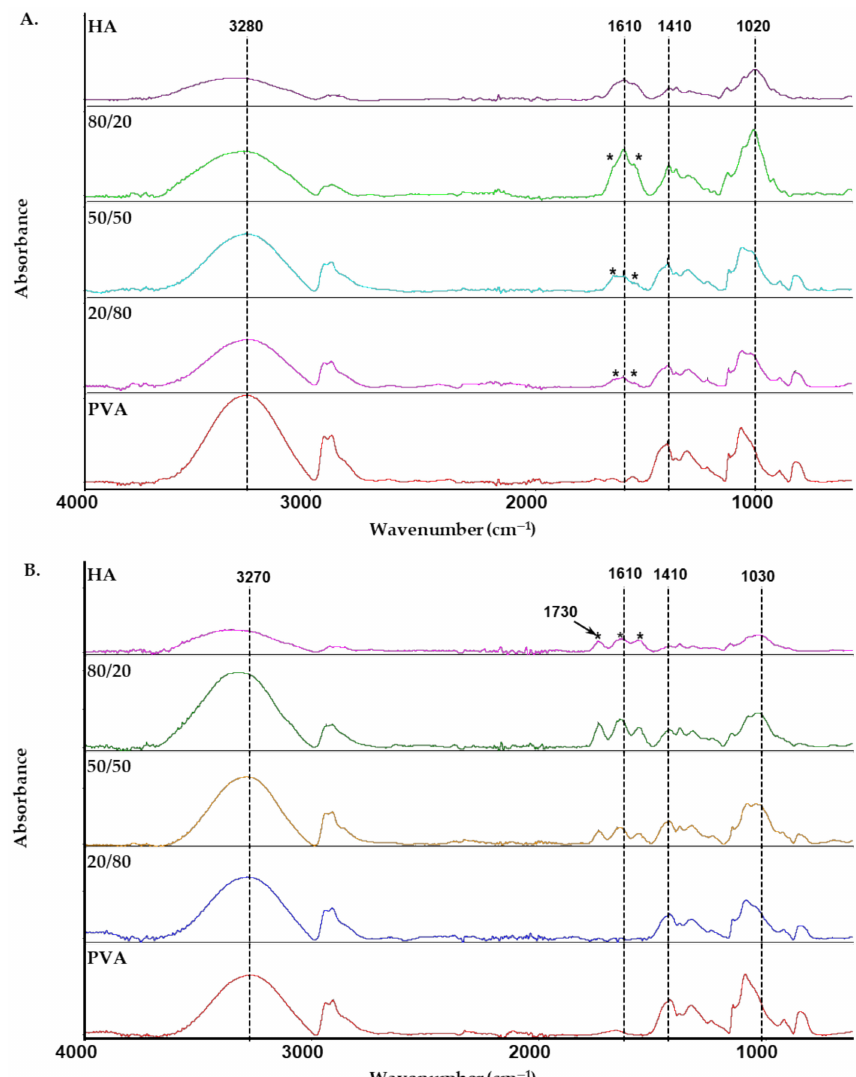
Figure 6. Attenuated Total Reflectance (ATR)–infrared spectra of HA, PVA and their blend films in various solvents: ( A ) distilled water; ( B ) 0.1 mol dm − 3 HCl. The interactions occurring in HA / PVA blend films between the components are visible by marked spectral changes, especially in the region of the stretching vibration of OH groups, the C-O stretching vibrations in alcohols and the amide I and II bands. The maximum of the OH stretching band of the − 1 − 1 HA / PVA blends is located between that corresponding to HA (3340 cm or 3310 cm ) and PVA (3280 − 1 − 1 cm or 3270 cm ). The spectra of blend films cast from distilled water show that two sub-bands at − 1 − 1 approximately 1653 cm and 1552 cm are intense (marked with an asterisk) and can be attributed to carboxylate groups of HA participating in one or more hydrogen bonds [42,44]. Additionally, the − 1 wide band at approximately 1020 cm shifts after blending HA with PVA, possibly due to interactions between -COO - and -OH groups of HA and -OH groups of PVA. For blend films cast from 0.1 mol − 3 − 1 dm HCl solution, the spectra of HA / PVA blends with w HA ≥ 0.5 showed bands at 1730 cm